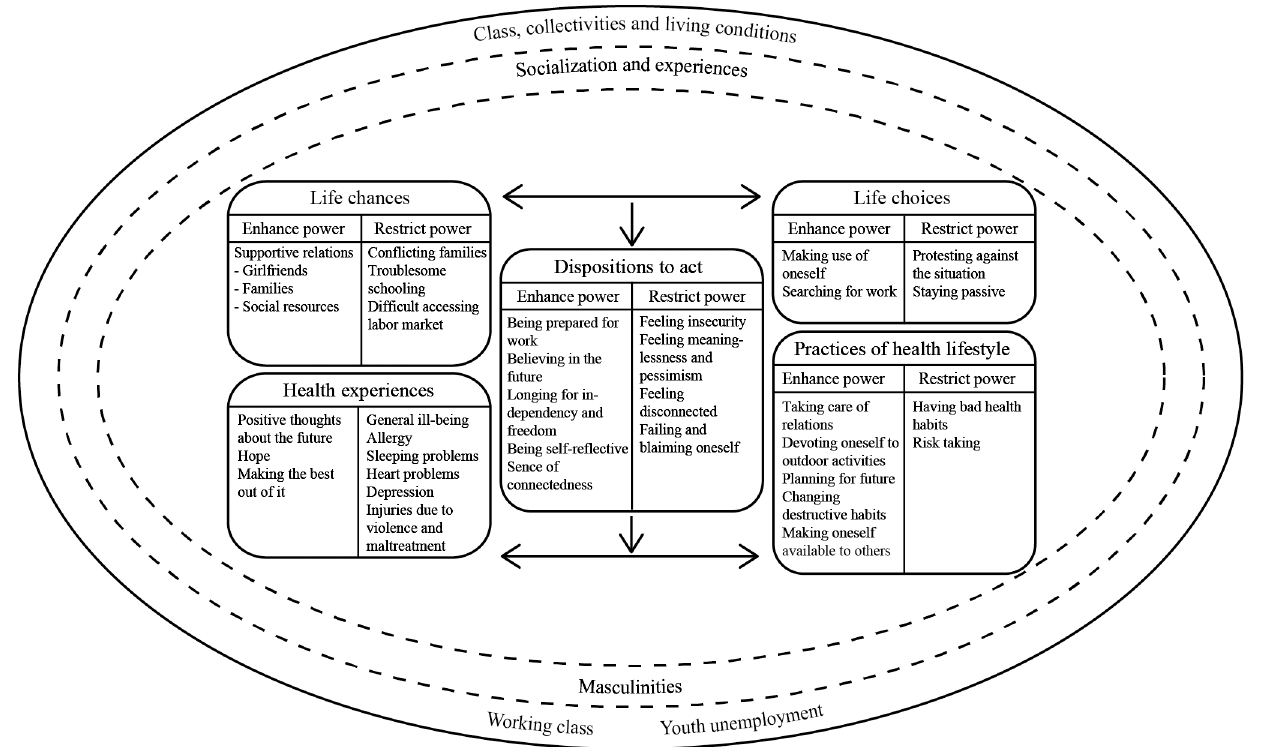
Fig 1. Model of life choices and life chances related to power and experiences of health. Our figure is a development of Cockerham ’ s health lifestyles theory within the framework of agency within structure [8].